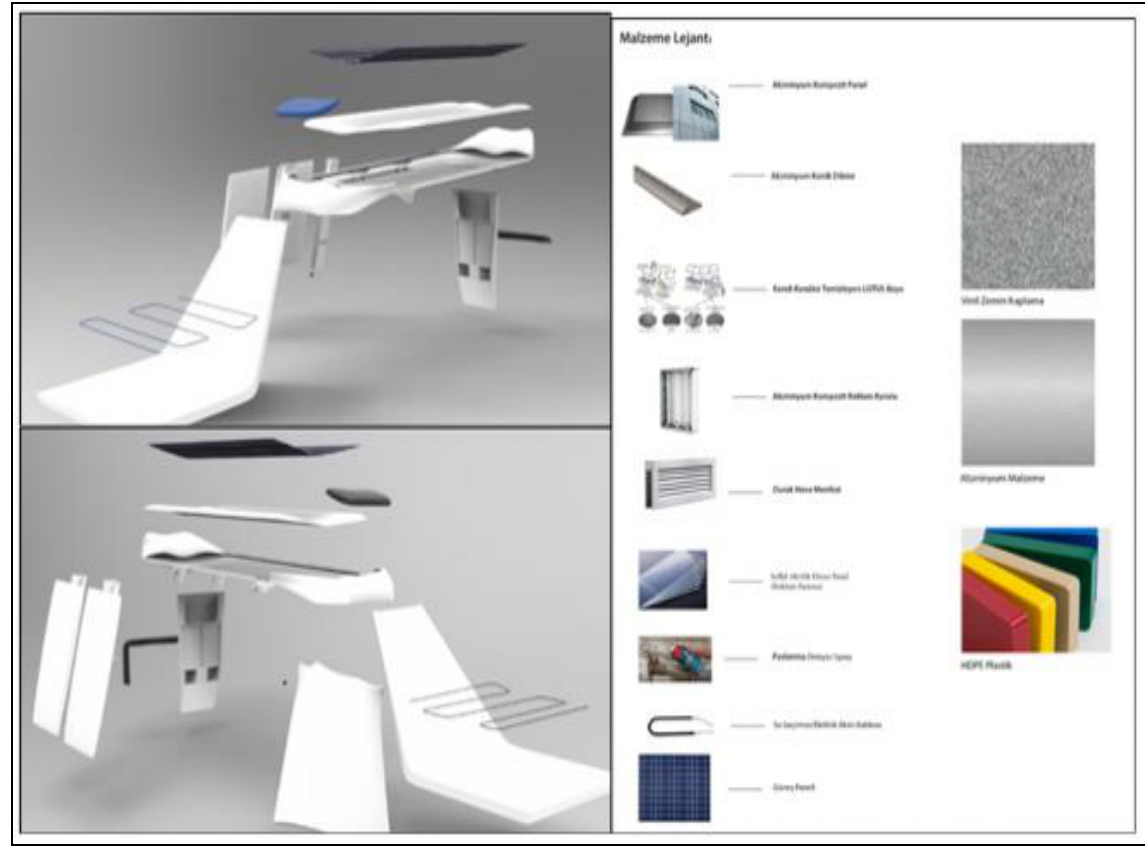
Figure 6 Smart bus stop system design sample (Original, 2018)